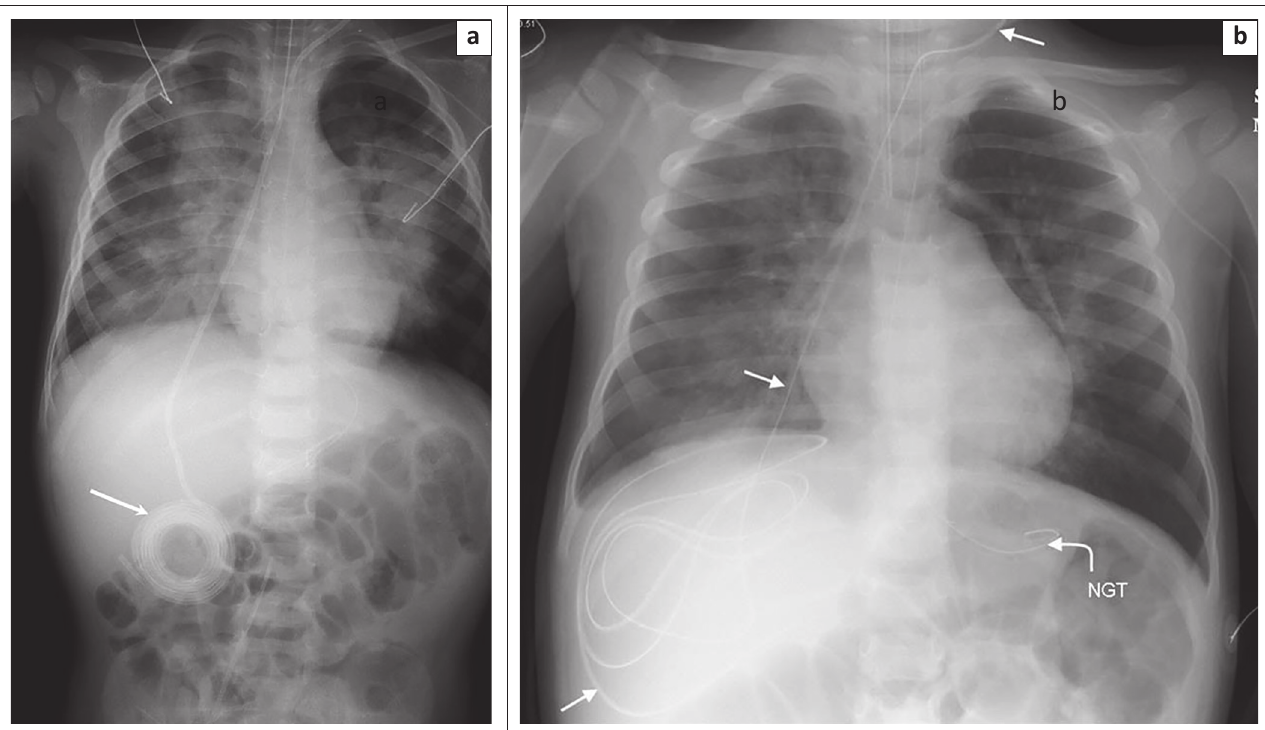
FIGURE 12: (a) The abdominal end of the ventriculo-peritoneal shunt (VPS) (arrow) is lying in an extraperitoneal location (between the anterior abdominal wall and the peritoneal cavity), unable to uncoil. Adequate CSF drainage was not possible and this resulted in raised intracranial pressure and neurogenic pulmonary oedema. (b) The ventriculo-peritoneal shunt (VPS) (arrows) in Figure 12a was repositioned and is now correctly positioned with the peritoneal cavity (freely lying). There has been a marked improvement in the pulmonary oedema changes as the raised intracranial pressure has been relieved.